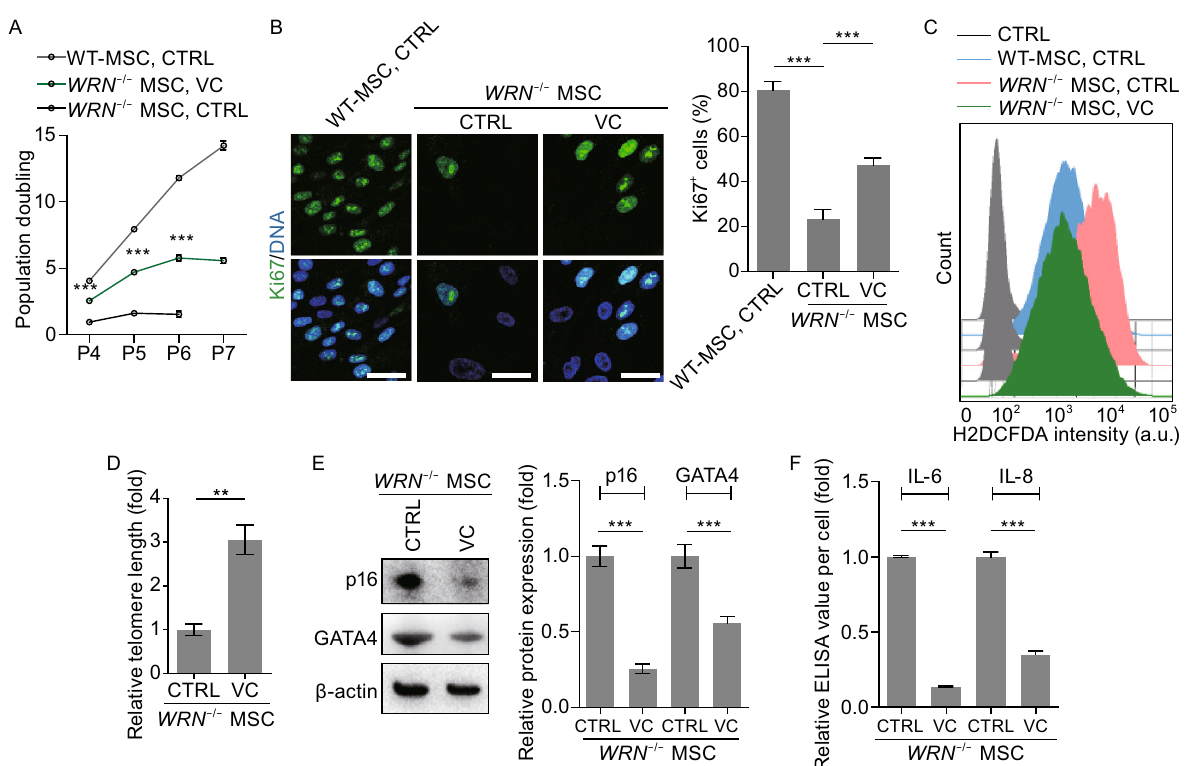
Figure 2. VC represses aging properties in WS MSCs. (A) Growth curve analyzing the population doubling of MSCs. (B) VC promoted proliferation in WRN -/- MSCs. Representative immuno fl uorescence staining (left) and quantitative analysis (right) of Ki67 in vehicle or VC treated (7 days) WT MSCs and WRN -/- MSCs. Scale bar, 50 µm. (C) H2DCFDA based measurement of reactive oxygen species (ROS) in vehicle or VC treated (7 days) WT MSCs and WRN -/- MSCs. (D) Telomere lengths of WS MSCs with or without VC treatment were measured by quantitative RT-PCR. (E) Expression of senescence-associated proteins p16 Ink4a and GATA4 was examined by Western blot, and quantitative results were shown on the right. (F) ELISA showing a decrease in IL-6 and IL-8 secretion in WRN -/- MSCs after VC treatment. The values were normalized by the cell numbers. Data are represented as mean ± SEM, ** P < 0.01, *** P < 0.001; n ≥